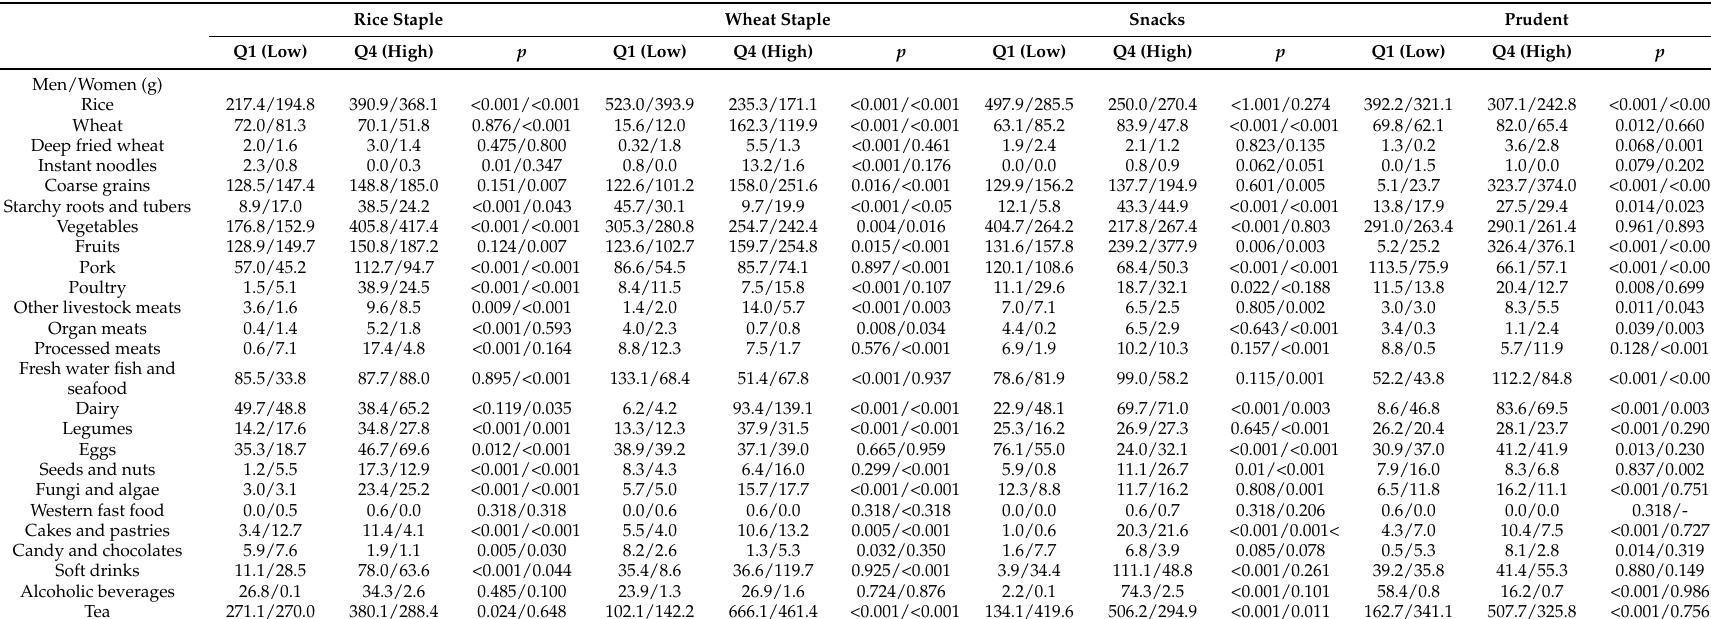
Table 1. Absolute amount of food groups by quartiles (Q) of dietary pattern